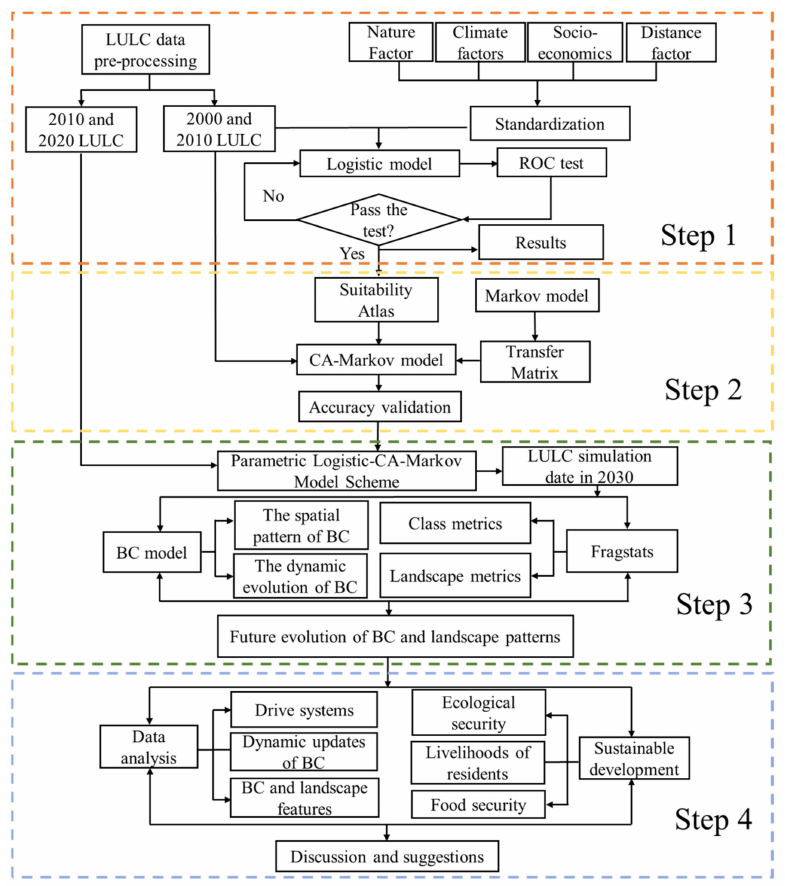
Figure 2. The overall technical route for this